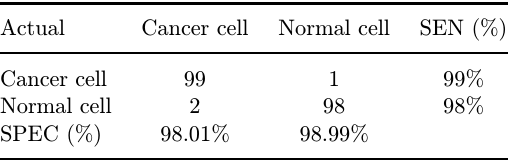
Table 2. Classi¯cation results obtained using SVM model corrected based on di®erences in chromatin distributions of normal and cancer